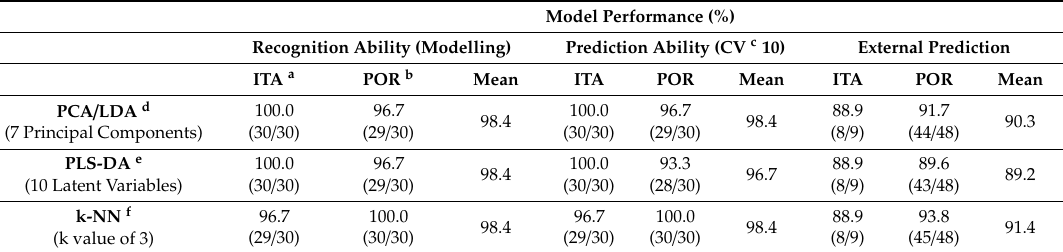
Table 1. Model performances in terms of recognition, cross validation (CV) prediction abilities and external prediction to classify chestnut honeys based on their geographical